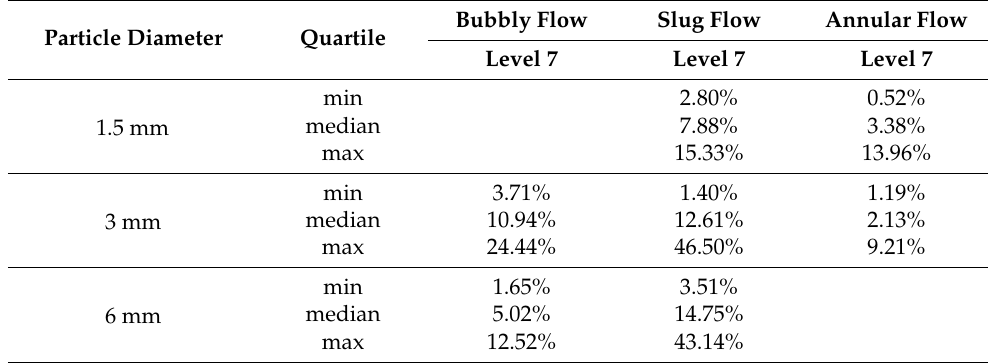
Table 5. Distributions of EMD energy spectrum on level